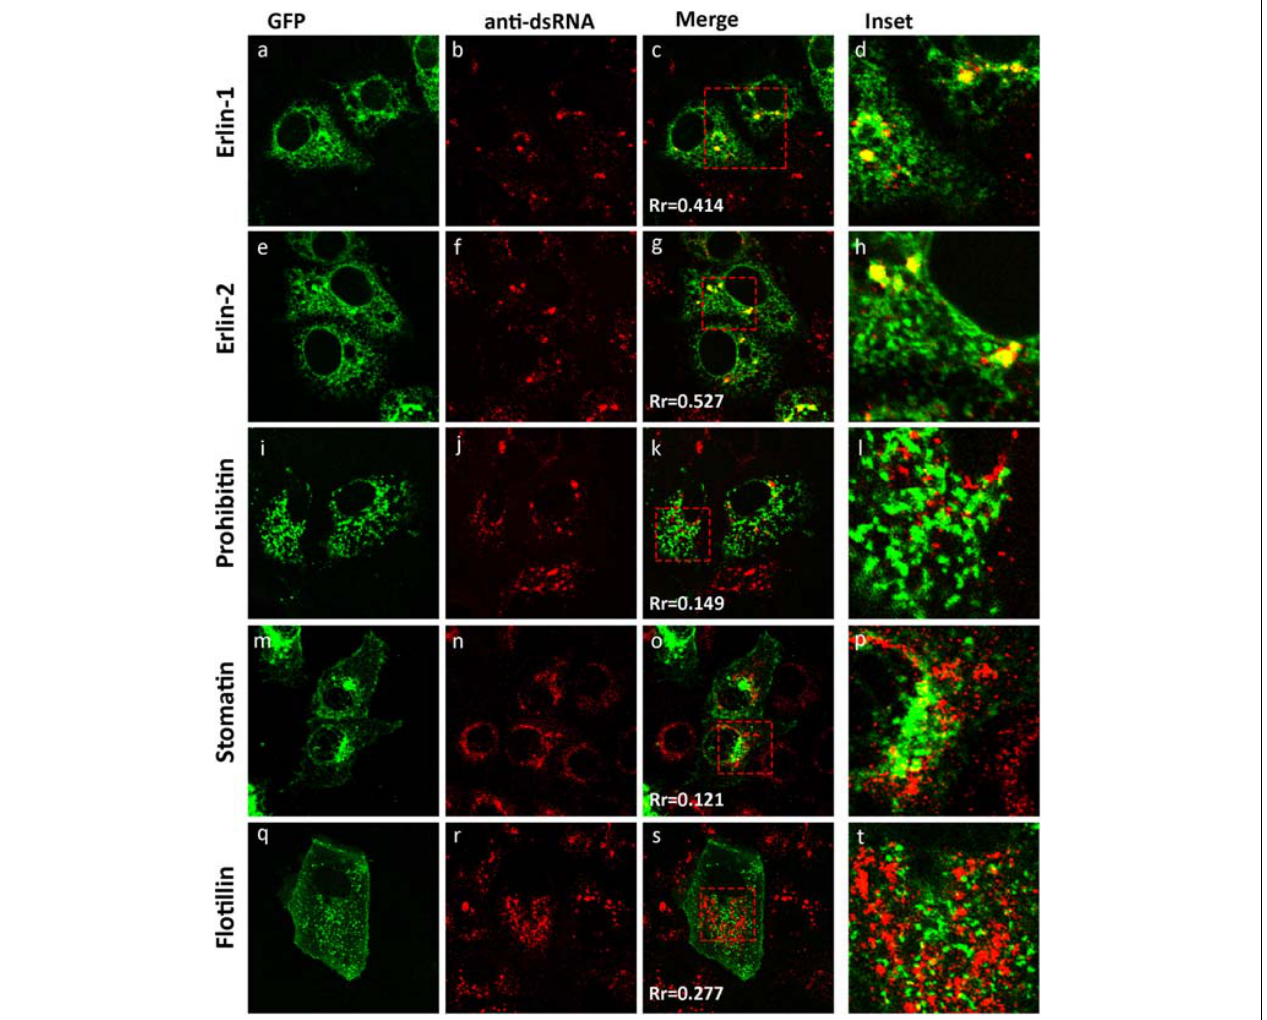
FIGURE 1 | The WNV KUN RC resides within cholesterol-rich domains in the ER. IF analysis of Vero cells transfected with recombinant eGFP-expression plasmids for 24 h (a,e,i,m,q) and subsequently infected with WNV KUN for an additional 24 h. Cells were immuno-stained with antibodies to dsRNA, and co-stained with Alexa Fluor 594 (b,f,j,n,r) . Prominent co-localization between dsRNA and erlin proteins is observed as a yellow hue in (c,h) only. Rr is the Pearson’ co-efficient (c,g,k,o,s) as assessed in Image J and serves as a quantitative measure of co-localization. Values above 0.4 indicate a significant degree of co-localization (d,h,l,p,t) . Represents the inset for the red box in (c,g,k,o,s) ,